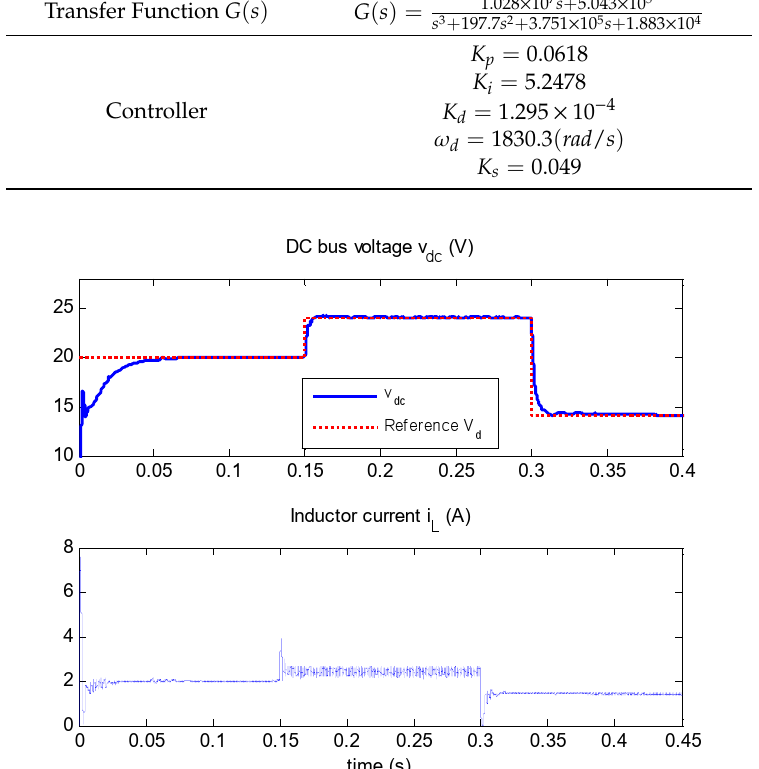
Figure 8. Tracking behavior of the controller in presence of a time-varying reference signal V d .